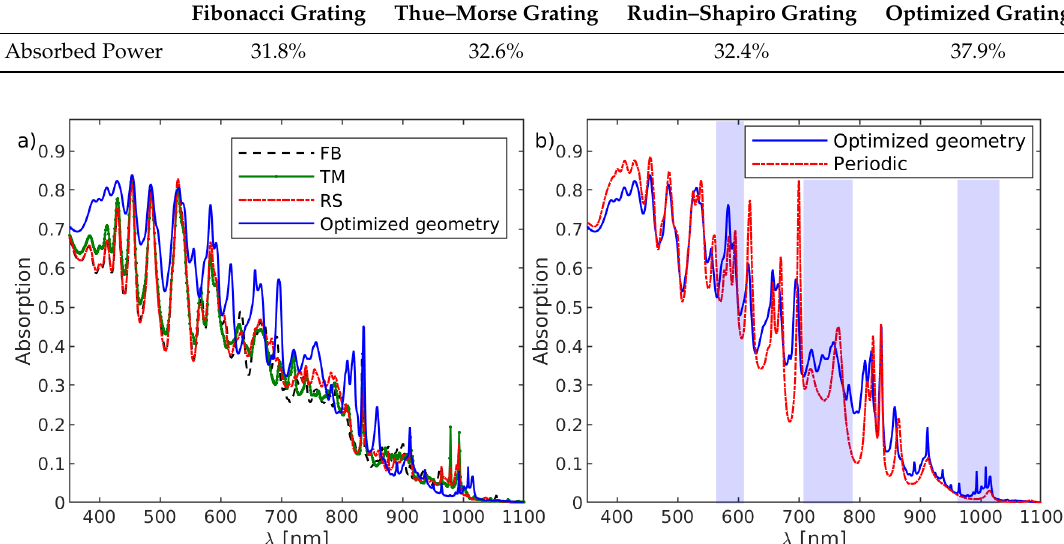
Figure 11. ( a ) simulated spectral response of the active layer’s optical absorption in structures with double gratings, such as the optimized semiperiodic double grating, the double grating based on Fibonacci (FB), Thue–Morse (TM) and Rudin–Shapiro (RS) sequences; ( b ) comparison between the optimized semiperiodic double grating and the fully periodic double